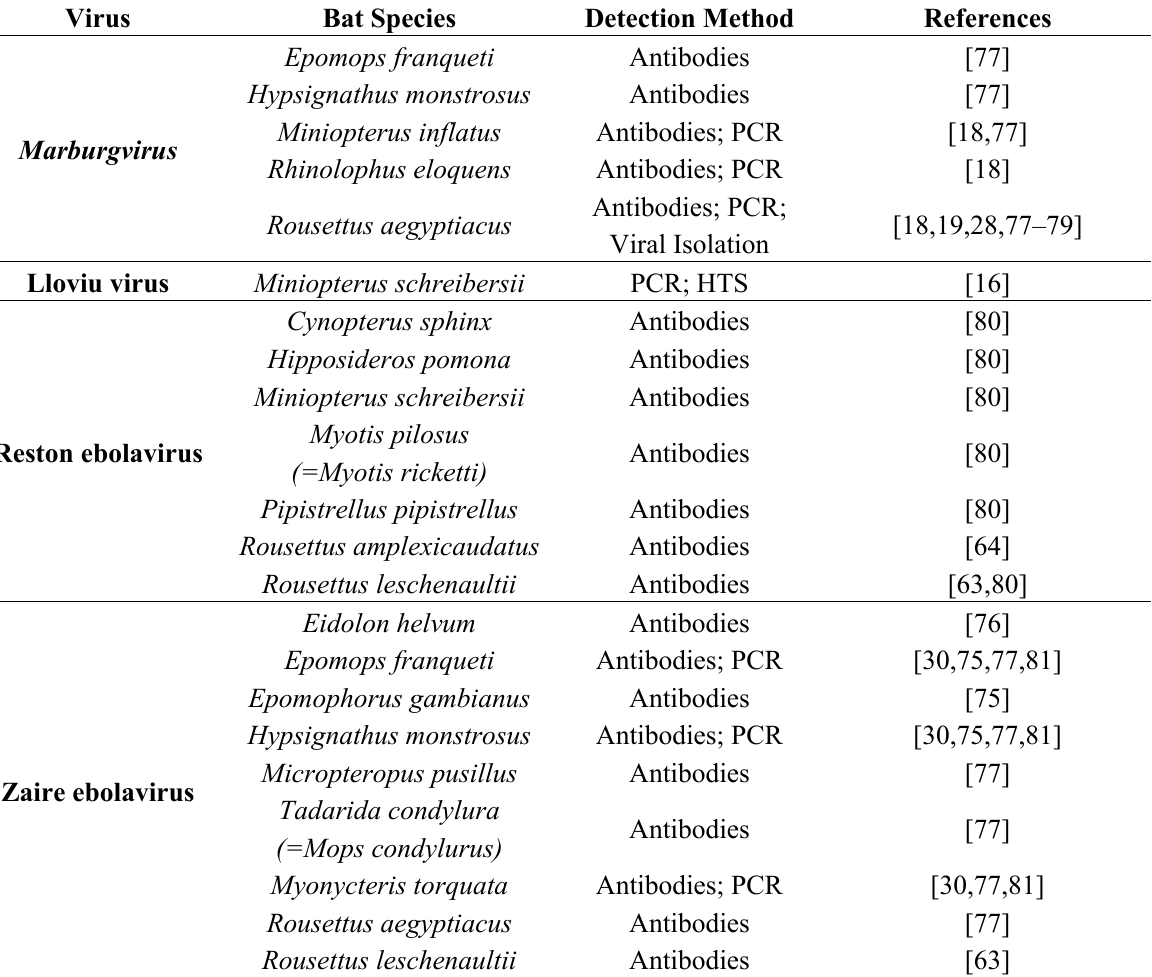
Table 1. Bat species found filovirus positive by serology or PCR. Bat species listed here for each virus were used to generate the geographic range maps in Figure 3. There are no currently known bat hosts for Bundibugyo , Sudan , or Tai Forest ebolaviruses . PCR = polymerase chain reaction; HTS = high-throughput sequencing. Species synonyms for Myotis pilosus and Tadarida condylura are used but original host name is retained from original